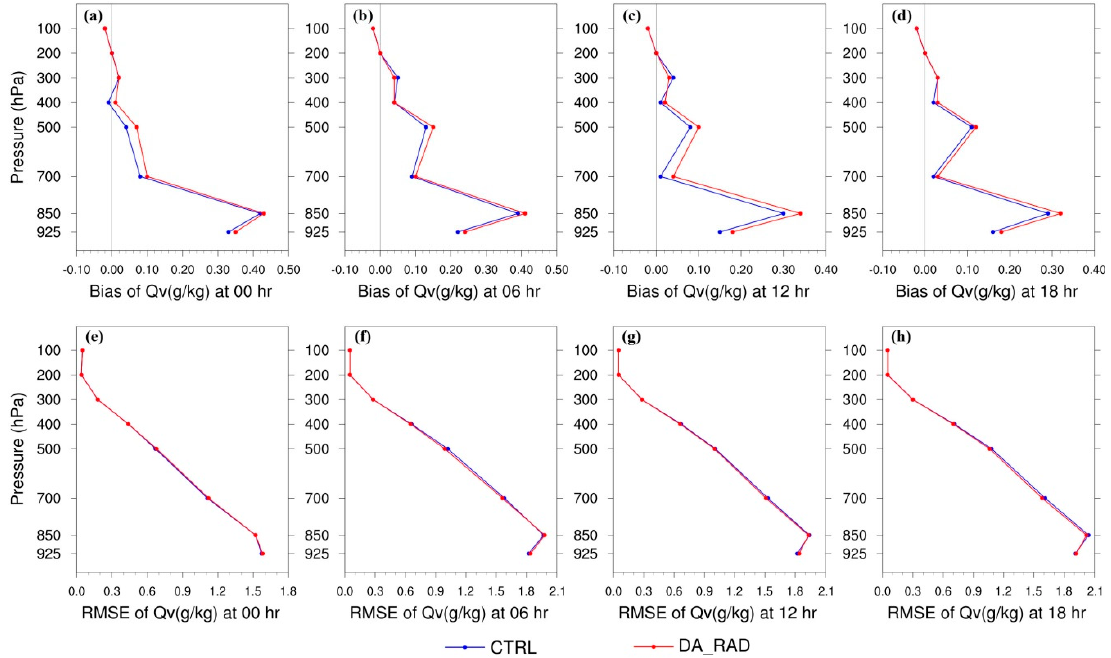
Figure 9. The average bias ( a – d ) and RMSE ( e – h ) of the vertical humidity (Qv: water vapor mixing ratio) profiles at hours 00, 06, 18, and 24 of the forecasts for retrospective runs (over the period of 1–12 August 2017) without (CTRL) and with (DA_RAD) satellite radiances.